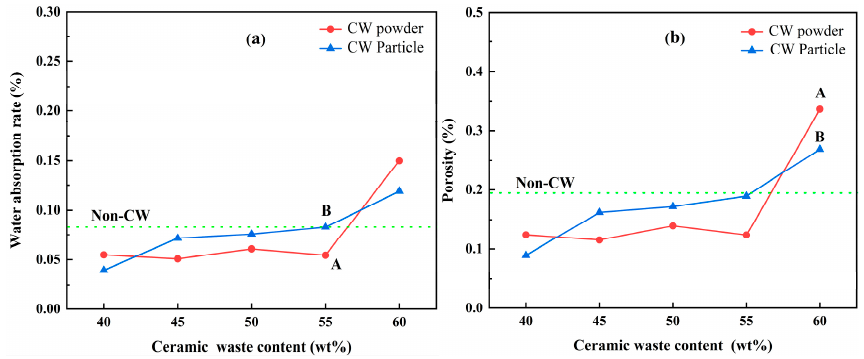
Figure 7. (a) Water absorption rate and (b) porosity of artificial stones with different ceramic waste